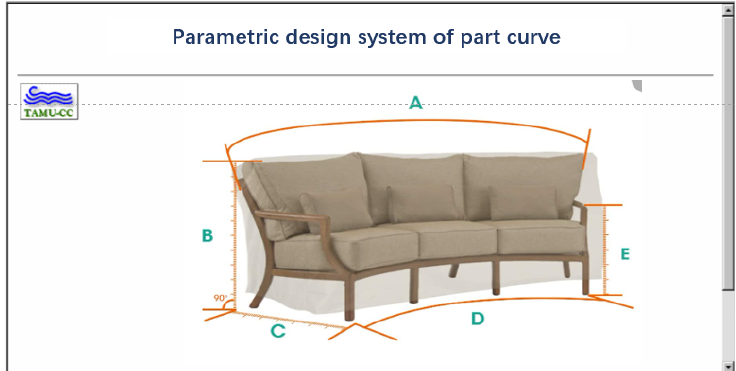
Fig. 12 Engineering drawing of a curved